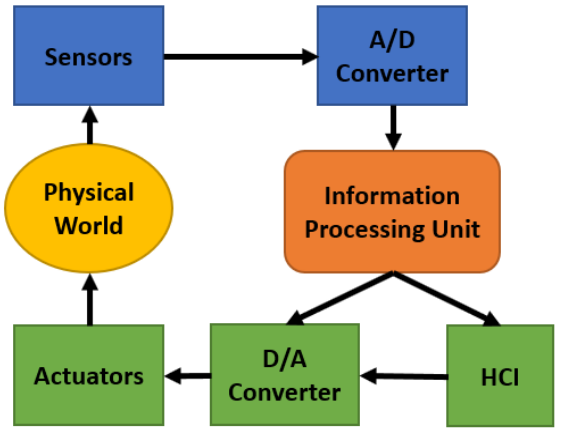
Figure 3. Components of a whole cyber physical system.